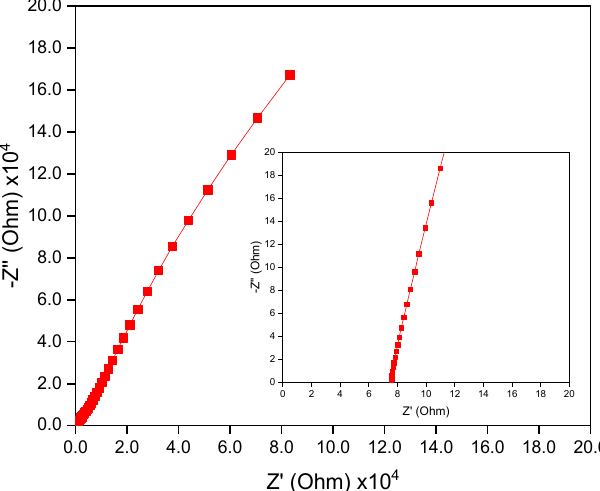
Figure 8. Nyquist impedance plot of hot-pressed BI-PI membrane. The inset shows a magnified view of the high-frequency region of the impedance spectrum.